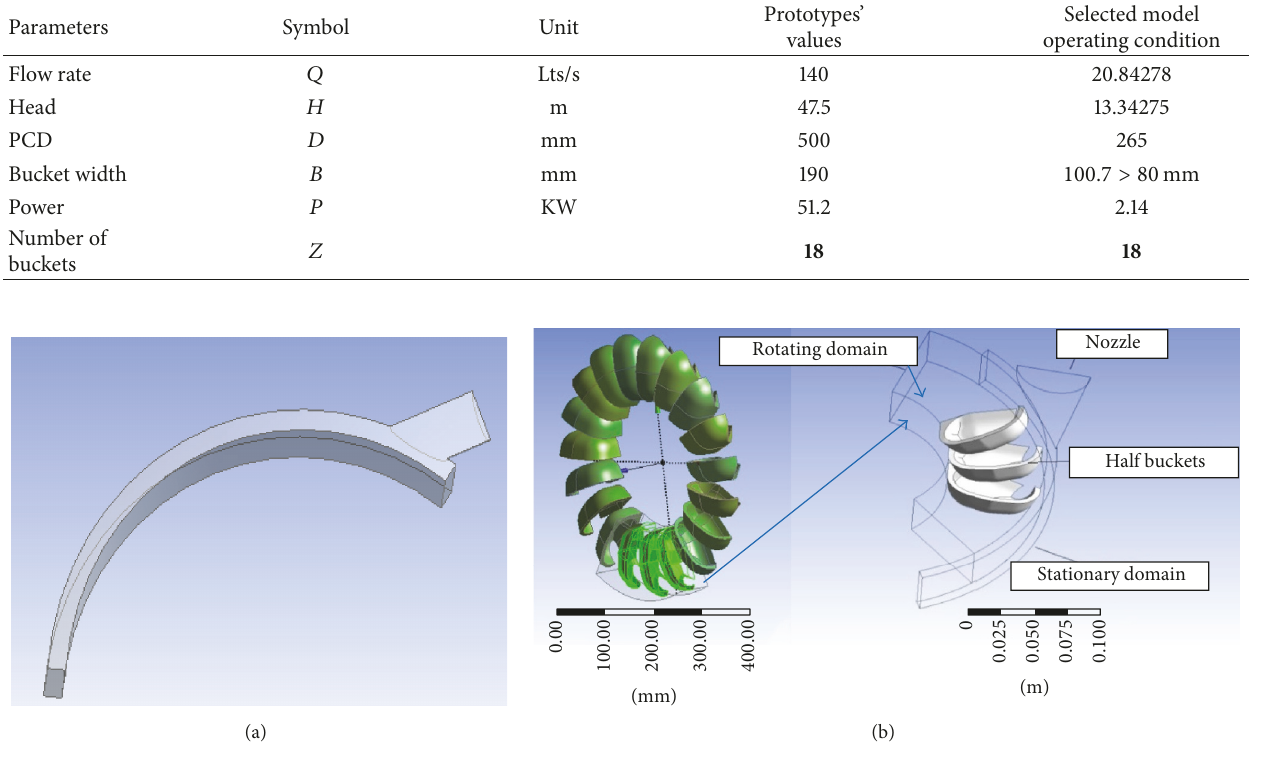
Figure 7: Domain geometries: stationary (a) and assembly of the rotating and stationary domain